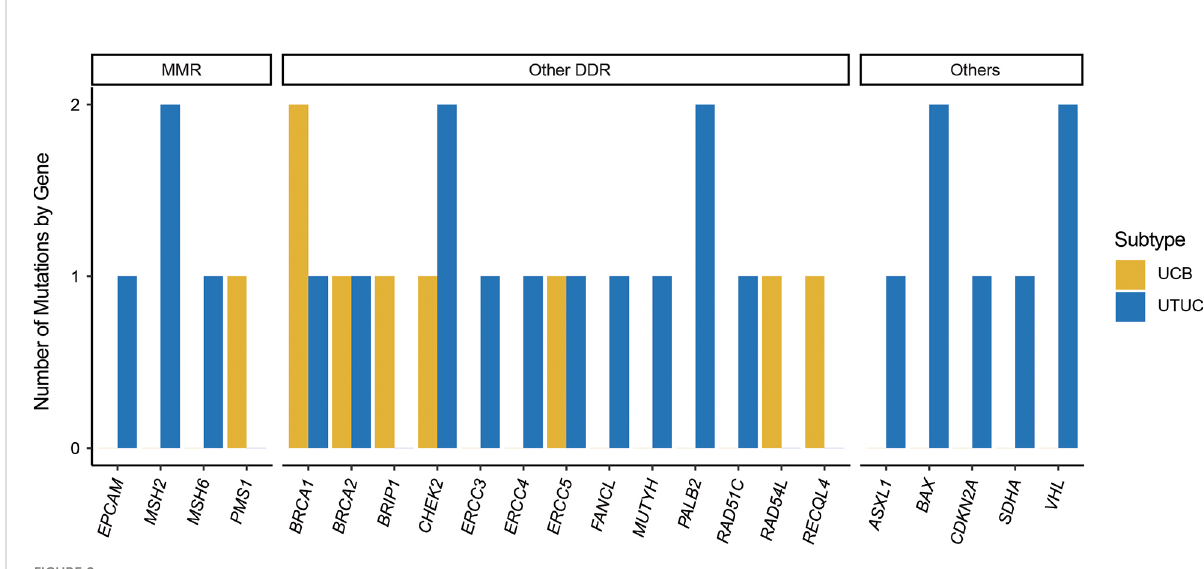
FIGURE 2 Germline pathogenic/likely-pathogenic variants in Chinese UTUC and UCB. UTUC, upper tract urothelial carcinoma, UCB, urothelial carcinoma of the bladder; MMR, mismatch repair; DDR, DNA damage